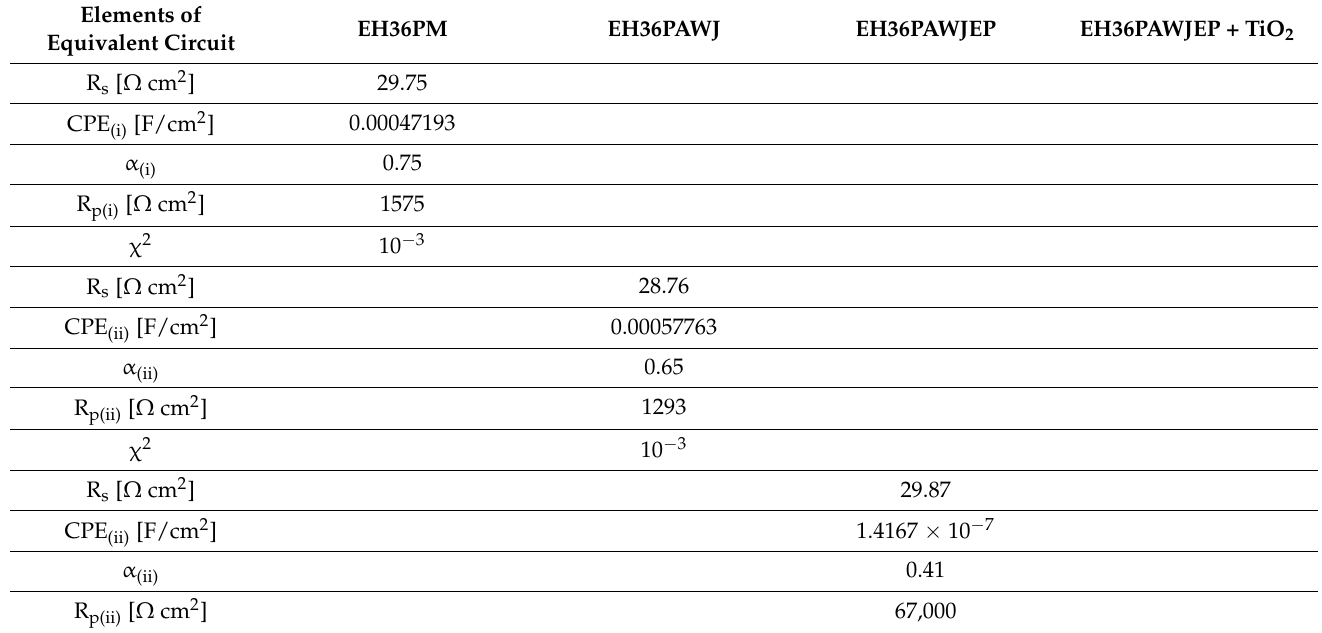
Table 7. The equivalent circuit elements values used for simulation of experimental data. Elements